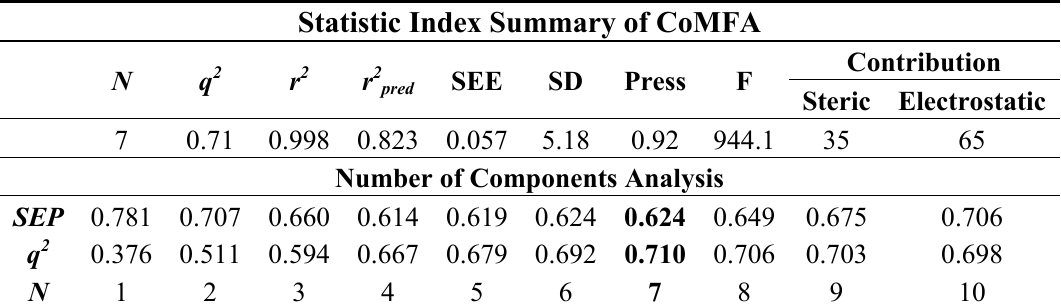
Table 2. Statistical parameters of the CoMFA model a .